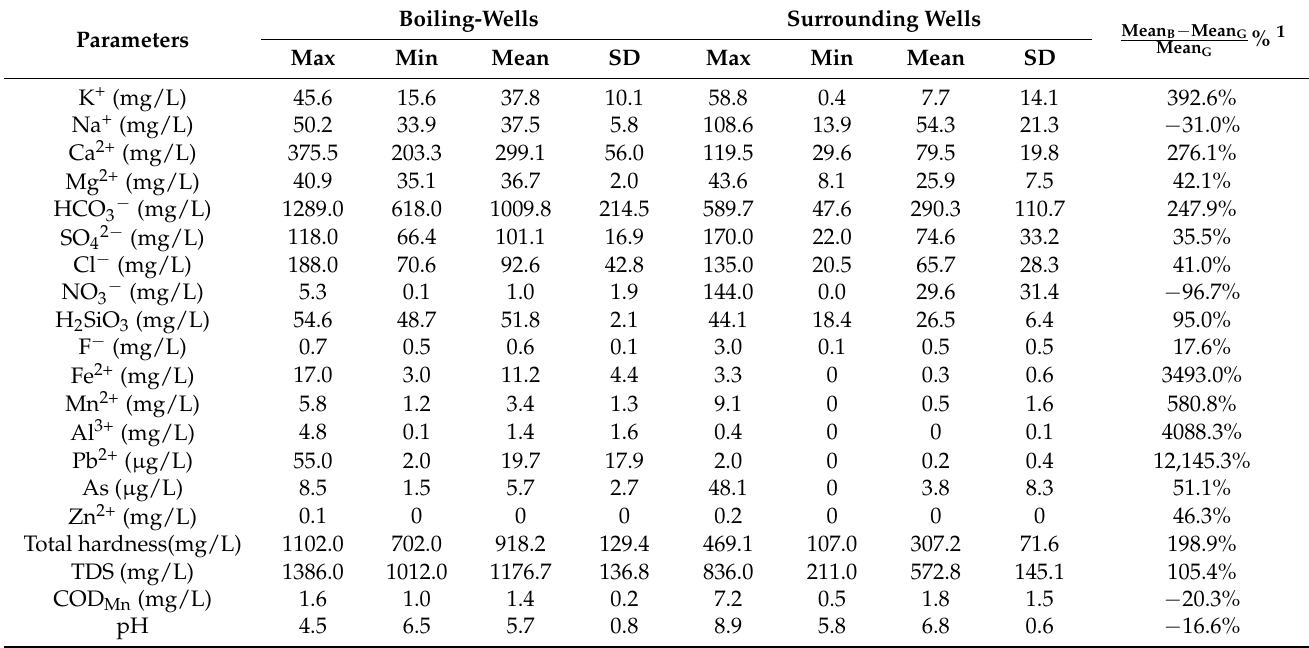
Table 2. Hydrochemical compositions of Boiling-Wells and peripheral wells.